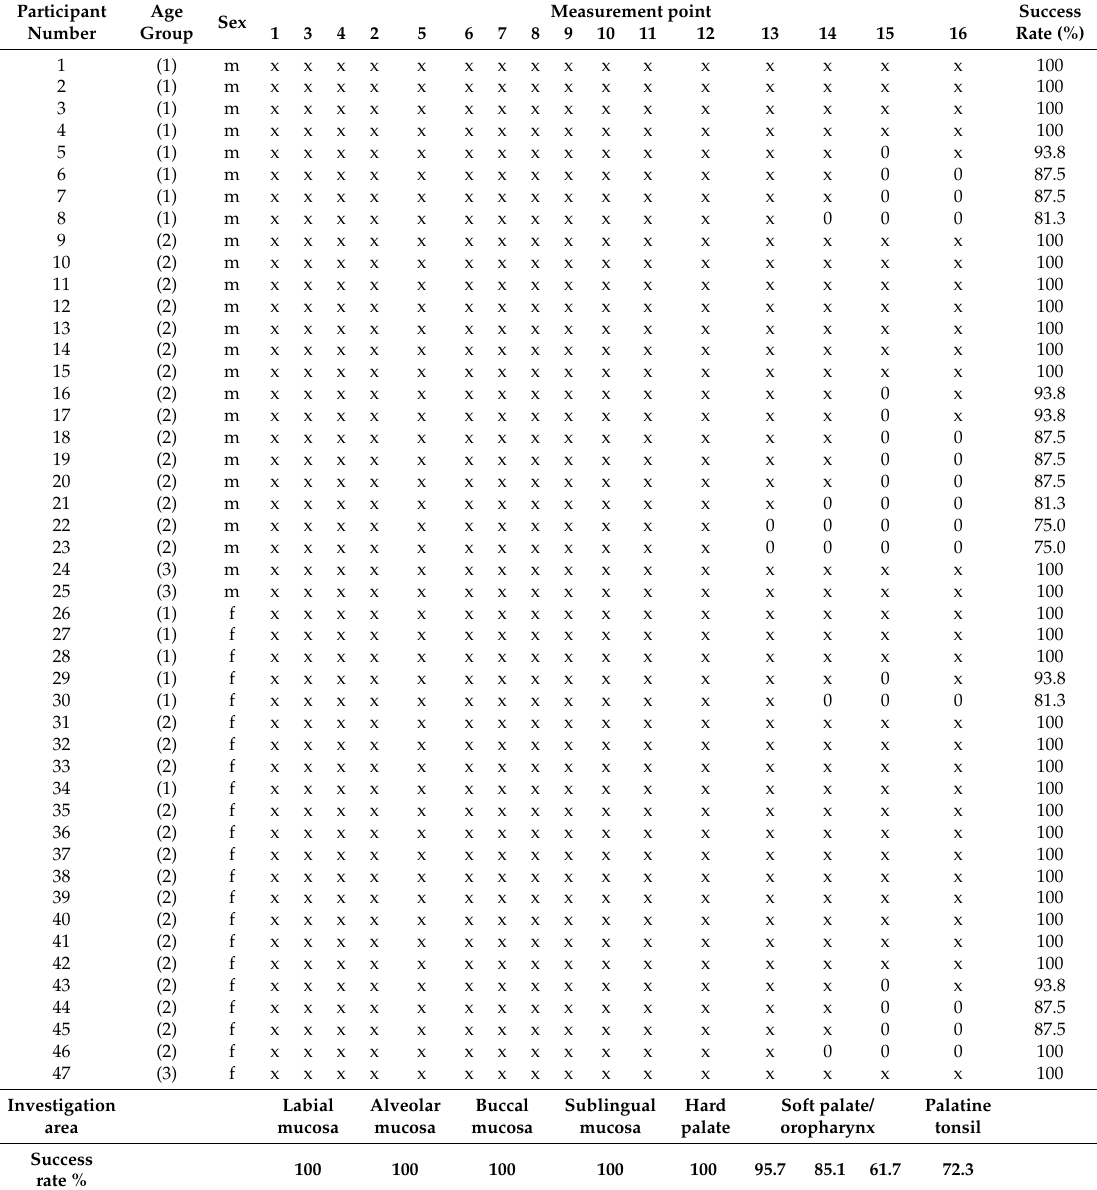
Table A3. Success rate of OCT data collection per measurement point, participant and investigation area.